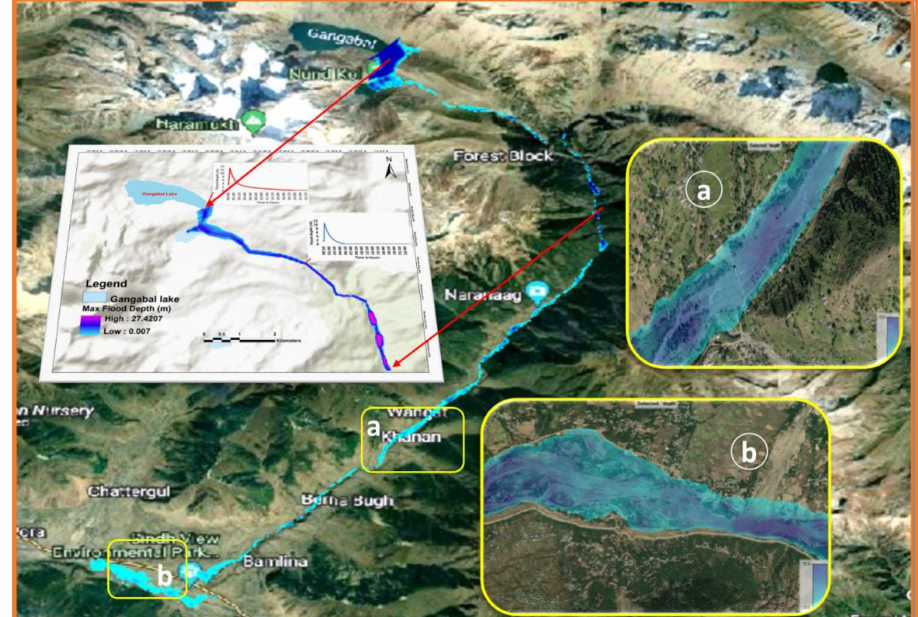
Figure 15. Spatial distribution of flood inundation from the lake outlet to the last selected location: ( a ) zoomed view of inundation at Khanam bridge; ( b ) routed channel confluence with Sind